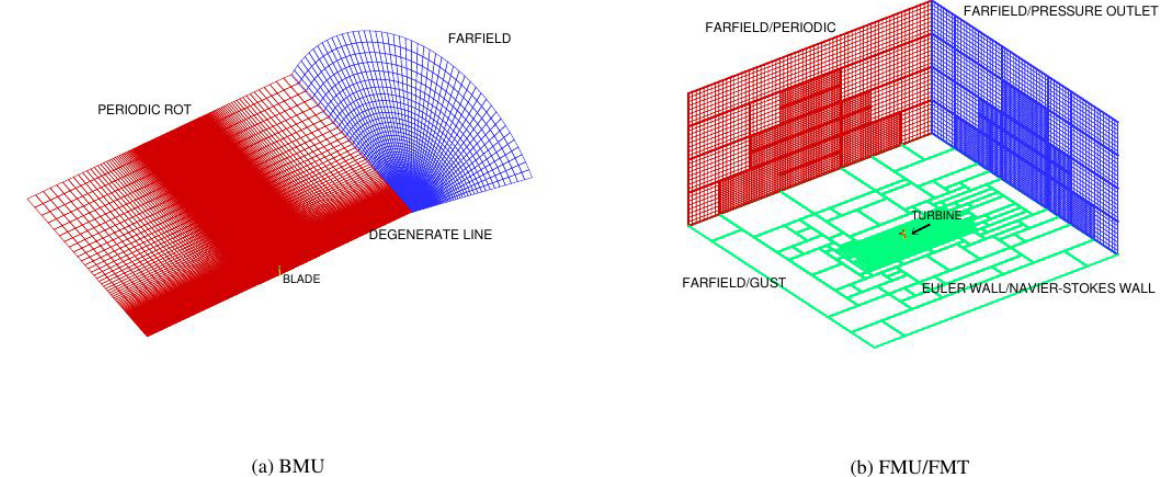
Figure 1. Details of the meshes and boundary conditions for BMU (a) and FMU and FMT (b) .